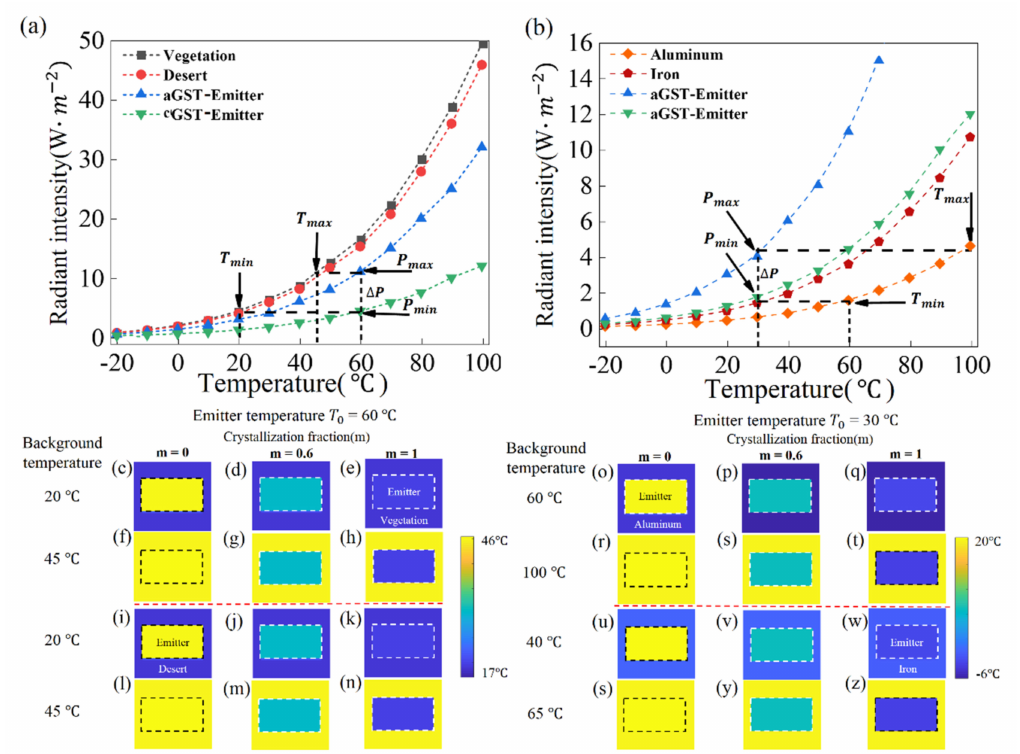
Figure 7. ( a ) The radiant intensity of the nonmetallic background environment including vegetation and desert, aGST- Emitter device, cGST-Emitter device at different temperatures in wavelength range of 3–5 µ m; ( b ) The radiant intensity of the metallic background environment including Al and Fe, aGST-Emitter device, cGST-Emitter device at different temperatures in wavelength range of 3–5 µ m. ( c – z ) IR images are simulated at different background temperatures and environmental background; ( c – n ) the fixed emitter temperature is 60 ◦ C at different crystallization fraction of GST (m = 0, 0.6, 1) and background is vegetation in above of red dotted line. On the contrary, background is desert in the bottom of red dotted line; ( o – z ) the fixed emitter temperature is 30 ◦ C at different crystallization fraction of GST (m = 0, 0.6, 1) and background is aluminum in above of red dotted line. In contrast, background is iron in the bottom of red dotted